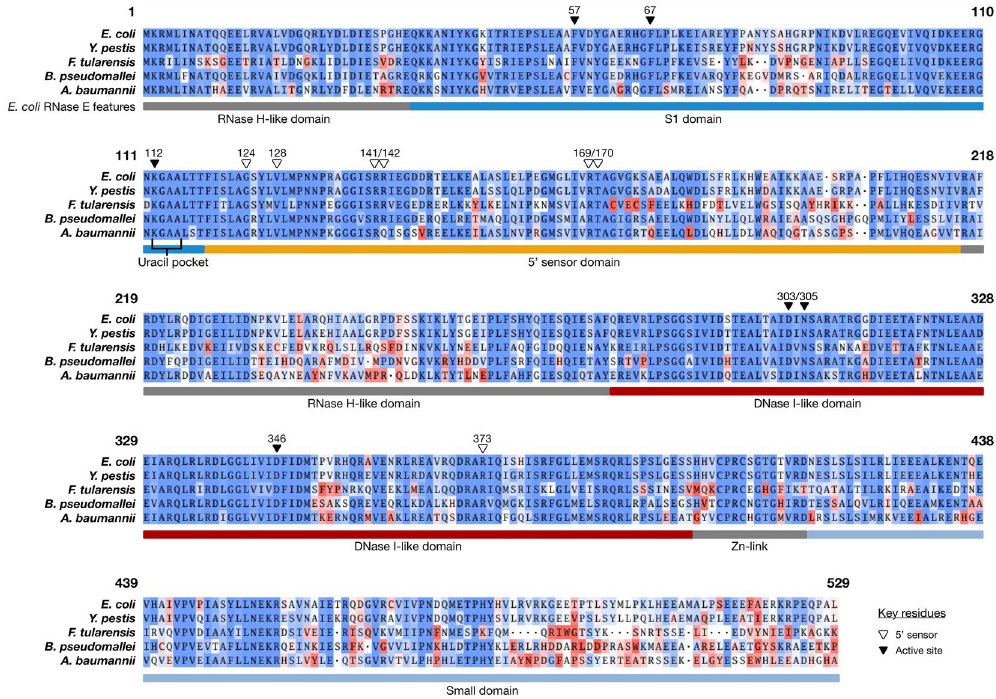
Figure 1. Multiple protein sequence alignment of RNase E catalytic domains. A multiple protein sequence alignment of RNase E homologues from E. coli , Y. pestis ., F. tularensis , B. pseudomallei and A. baumannii . The region corresponding to the catalytic domain is shown and is coloured in accordance with amino acid side chain using a heatmap based on a BLOSUM62 matrix. Coloured bars below the alignment indicate the subdomains within the catalytic domain of E. coli RNase E (see Supplementary Fig. S1 for a structural representation). The alignment numbering is based on E. coli RNase E. Key amino acids forming the 5 ′ sensor pocket and active site 18,25 are denoted with white and black triangles,